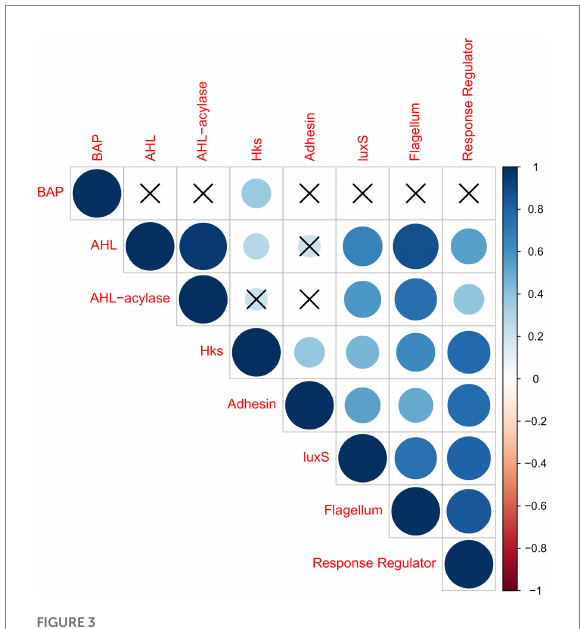
FIGURE 3 Correlation coefficient matrix for putative biofilm-effectors in samples from cheeses and milk, plotted as an upper triangle graphic, showing the correlation coefficients as circles (Pearson correlation). Insignificant markers (X) indicate which pairs of variables are not significantly related (value of p > 0.05). The stronger the correlation is, the larger the circle. Positive correlations are displayed in blue, while negative correlations would be displayed in red. The effectors studied were: adhesin, BAP, flagellum-related, intraspecific QS (AHL, HK, and RR), interspecific QS (LuxS), and QQ